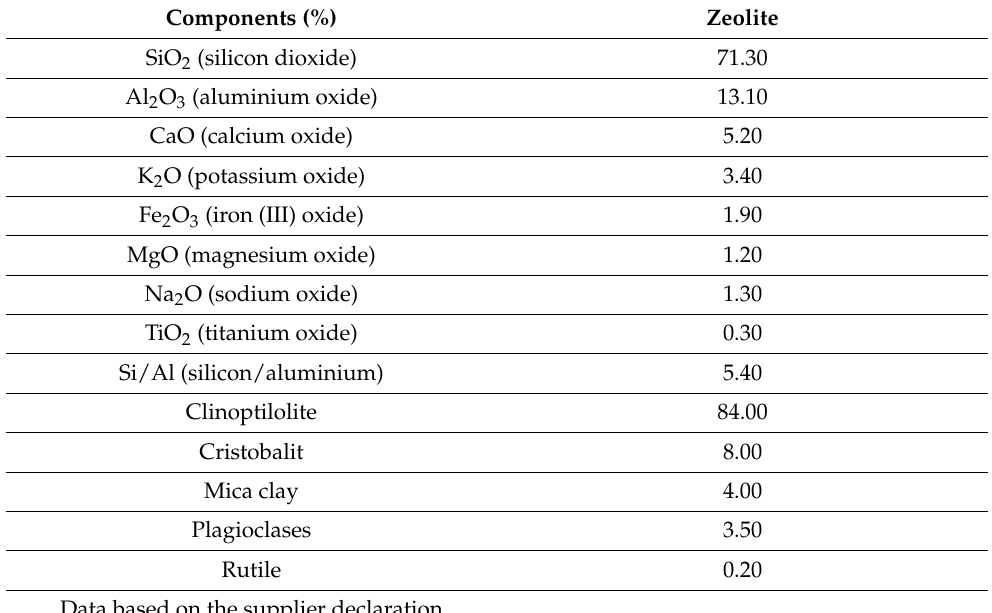
Table 1. Chemical composition of